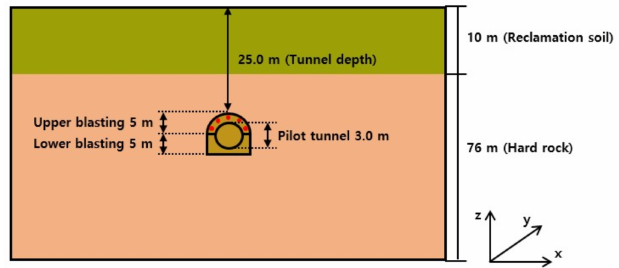
Figure 4. Ground and structure